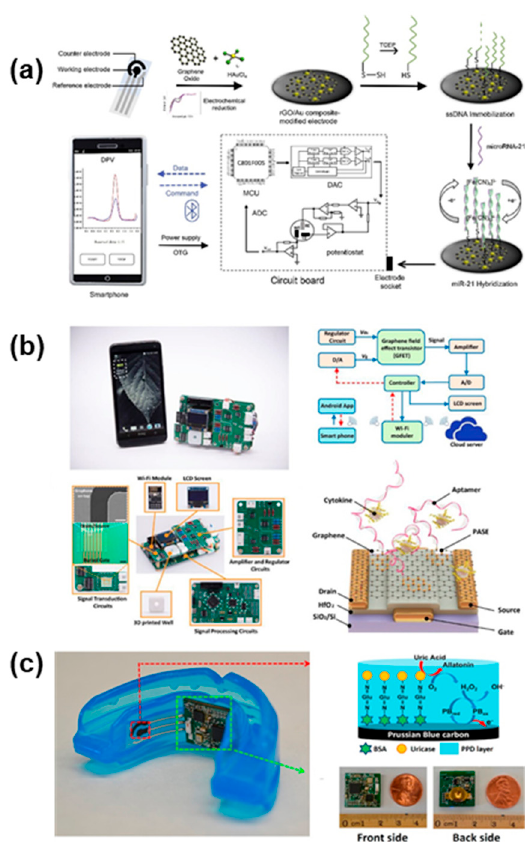
Figure 8. Integrated salivary biosensing systems as POC diagnostic tools for oral cancer biomarkers detection ( a ) Portable biosensing system for the rapid and accurate detection of miRNA in human saliva. Reprinted with permission from ref. [113]. Copyright 2020 Elsevier. ( b ) Handheld fully integrated nano biosensing device for ultrafast cytokine detection in human saliva samples. Reprinted with permission from ref. [101]. Copyright 2019 Elsevier. ( c ) Mouthguard-based biosensing systems with integrated electronics for selective intraoral detection of uric acid. Reprinted with permission from ref. [106]. Copyright 2015 Elsevier.